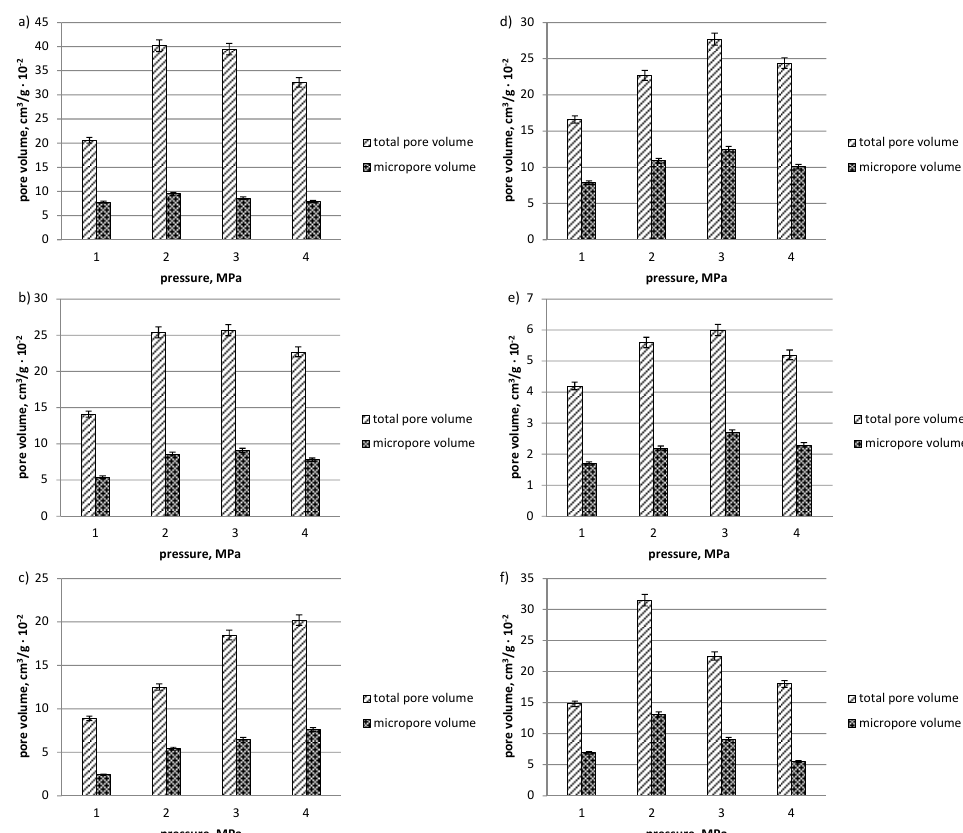
Figure 3. Variation in pore volume of chars: ( a ) object 1; ( b ) object 2; ( c ) object 3; ( d ) object 4; ( e ) object 5; and ( f ) object 6 with pressure applied in pyrolysis.